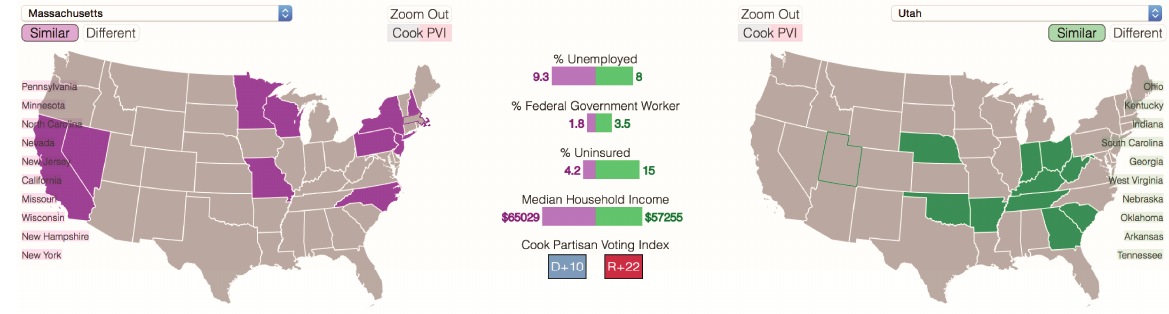
Figure 9. The set of states with similar keyword use sometimes follows political and cultural lines. Similar states to Massachusetts are shown on the left . Similar states to Utah are shown on the right